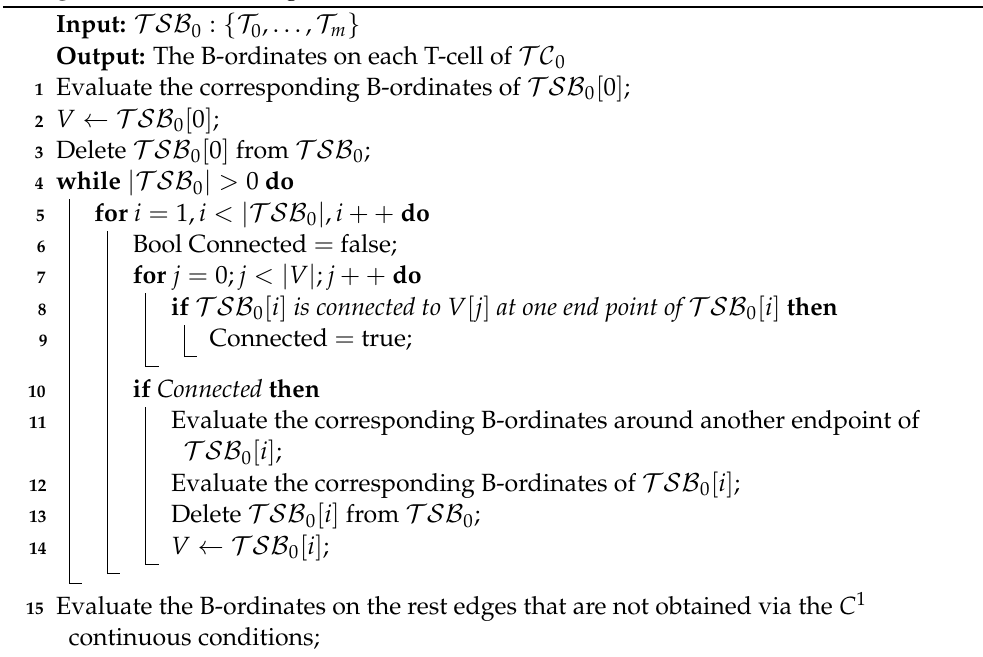
Algorithm 2: Evaluating the B-ordinates for each T-cell in T C 0 ∈ T k + 1 [35].